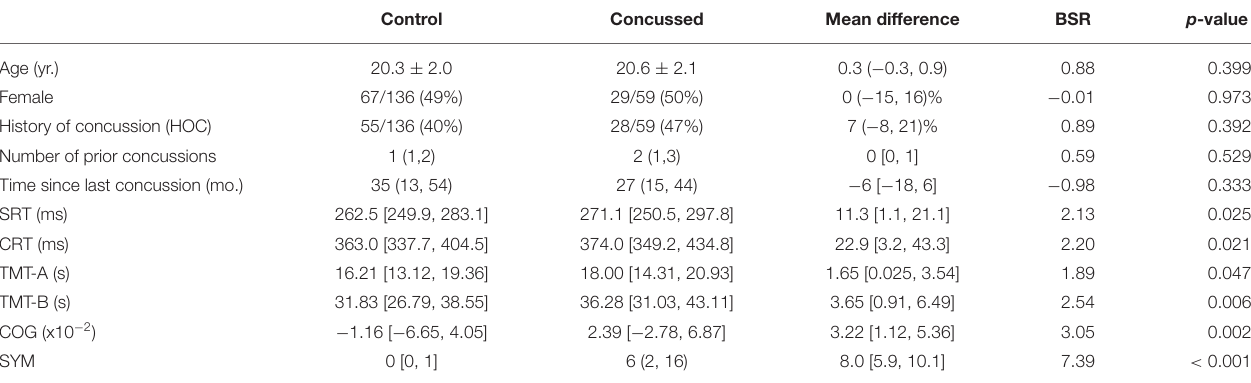
TABLE 1 | Demographic, cognitive, and symptom data for athletes with concussion and controls. Control Concussed Mean difference BSR p -value Age (yr.) 20.3 ± 2.0 20.6 ± 2.1 67/136 (49%) 29/59 (50%) 0 ( − 15, 16)% 0.973